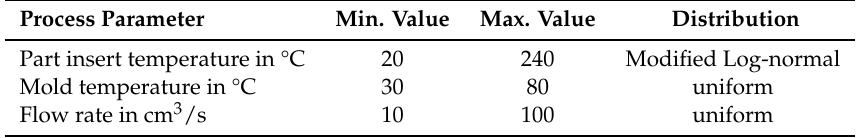
Table 1. Investigated process parameters and the corresponding sampling distribution.